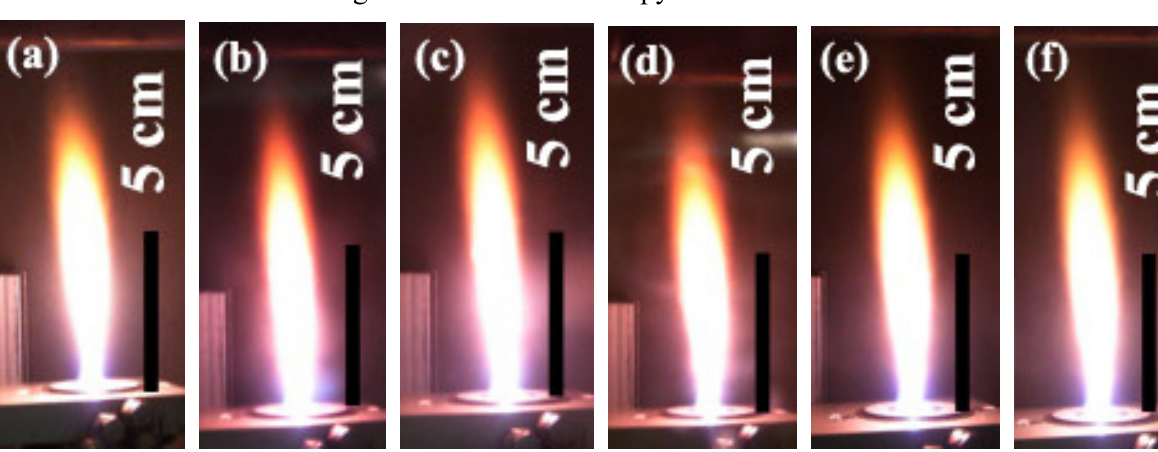
Figure 2. Spray flame (0.5 M zinc naphtenate and Pd (acac) in toluene/acetonitrile 2 (80/20 vol%)) of (a) pure ZnO, (b-f) 1-5 mol%Pd/ZnO nanoparticles producing 5 ml/min of liquid precursor feed rate and dispersed by O (5 l/min) at 1.5 bar pressure drop across 2 the nozzle tip. The flame heights were observed ranging from 10-12 cm with slight increasing the combustion enthalpy and Pd